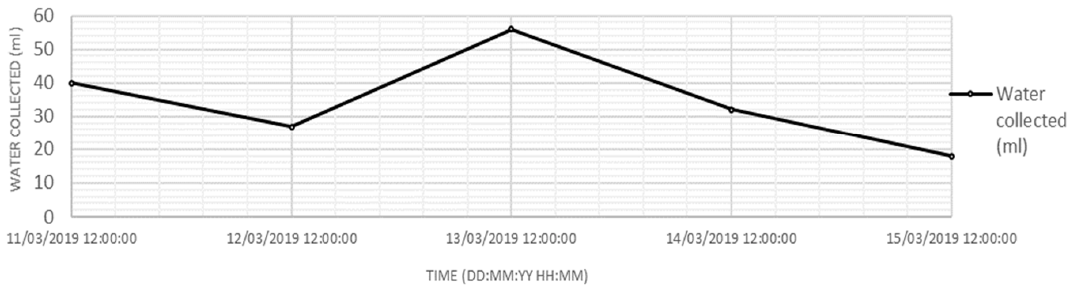
Figure 11. The amount of water collected by solar still in the second week.